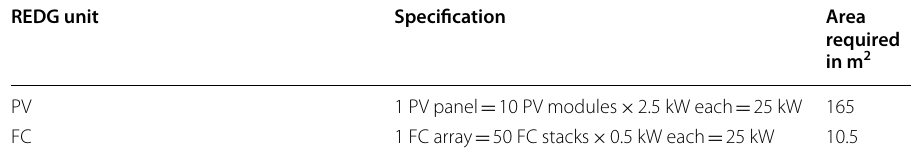
Table 2 Details of REDG units used in the study REDG unit